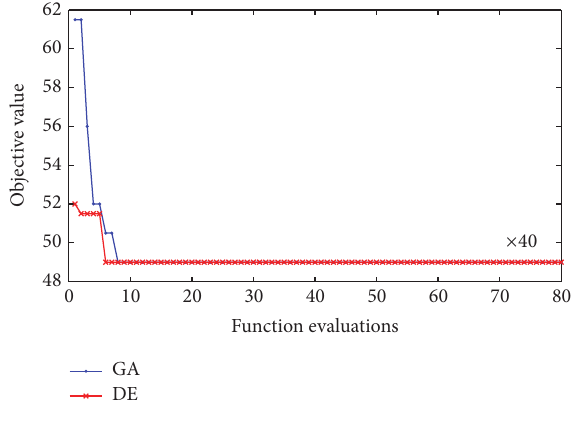
Figure 5: Track of the best solutions.